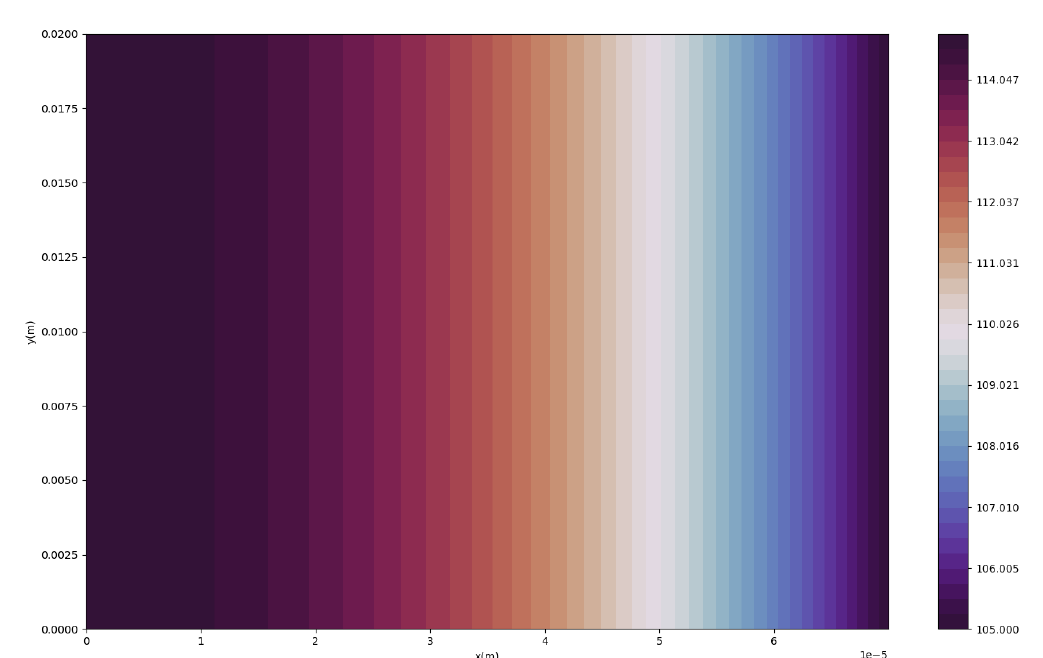
Figure 17. Steady temperature used as the initial condition in the 2D model.